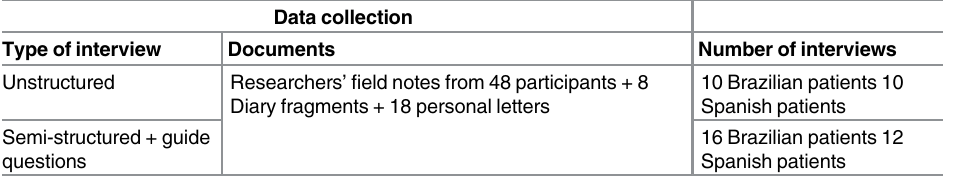
Table 1. Data collection